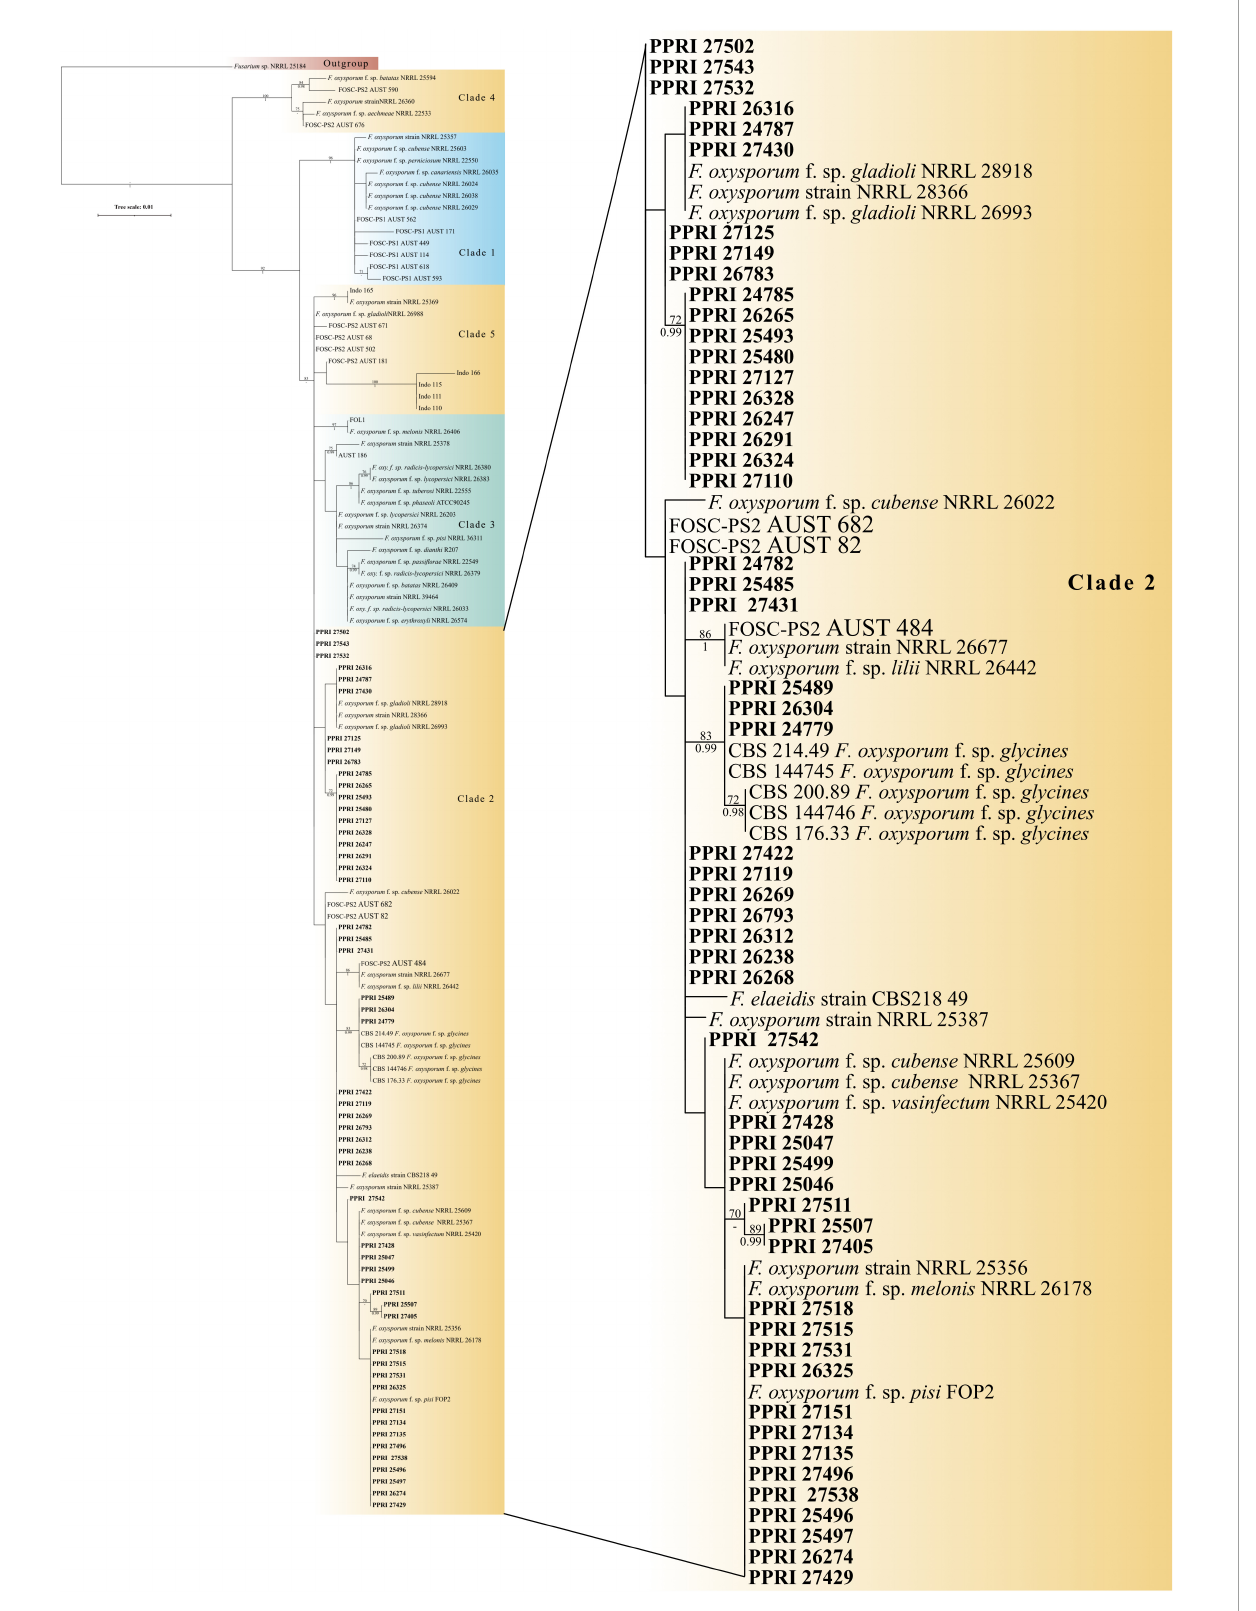
FIGURE5 Phylogenetic tree of the FOSC dataset inferred from the tef-1 α gene region for 123 taxa. Isolates from the GGHNP are indicated by PPRI number and are marked in bold. Branch support values are indicated as ML-BS/PP values ( > 0.98/ > 70%) above the branches at the corresponding nodes.